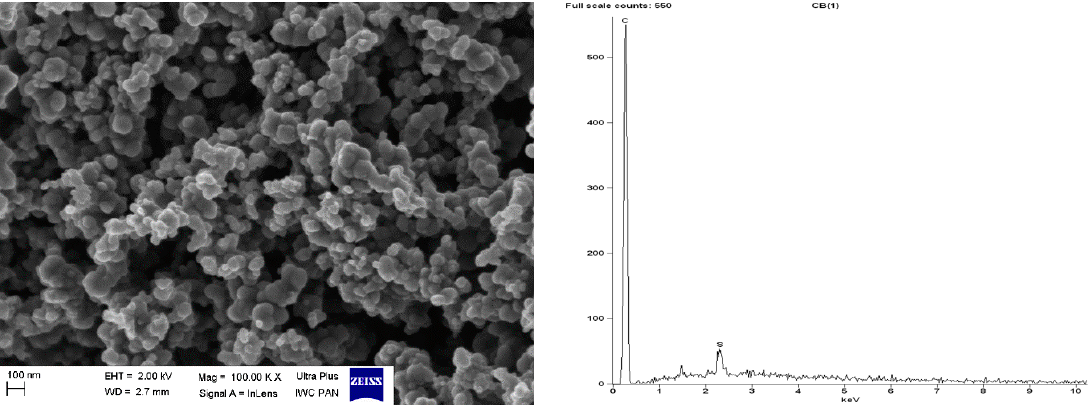
Figure 15. SEM with EDS analysis for pure CB.